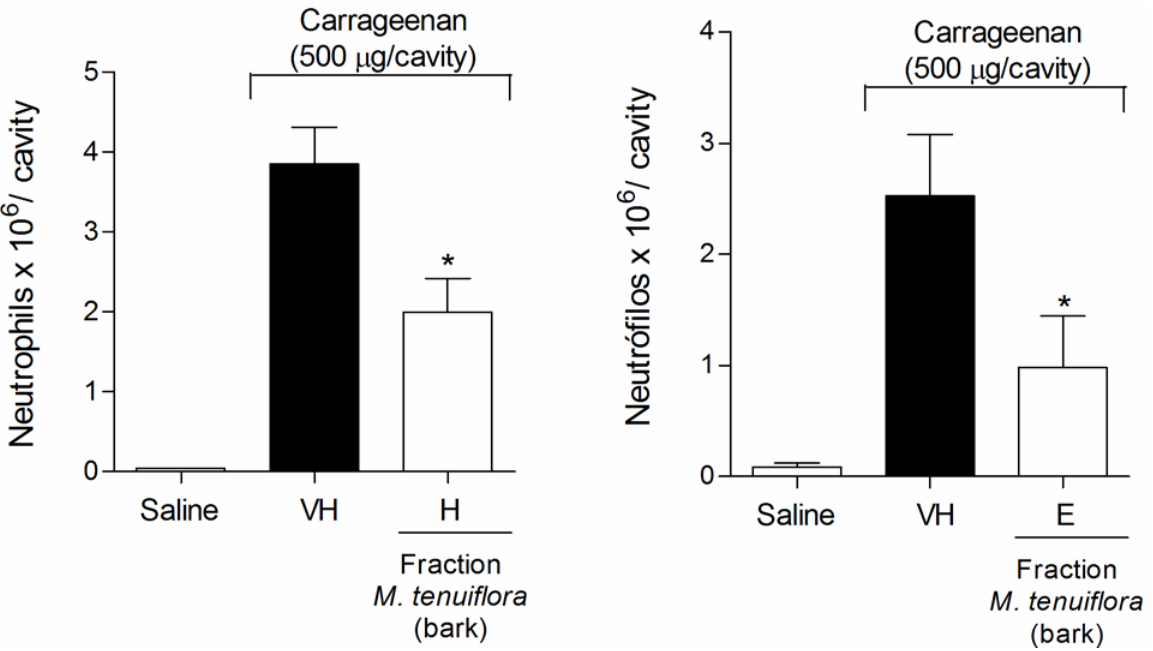
Fig 14. Effect of the hexane (H) (200 mg/kg) and EtOAc (E) (50 mg/kg) M . tenuiflora bark extract fractions on neutrophil migration to the peritoneal cavity of mice after Cg administration. VH is the vehicle group (negative control). The results are presented as the mean ± S.D. (n = 8). Statistical significance was calculated by ANOVA followed by Bonferroni's test. * P < 0.05 compared to the vehicle-negative control treated group.